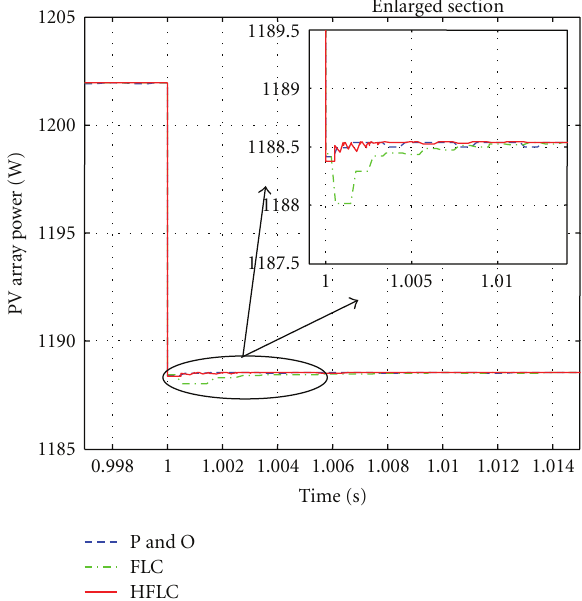
Figure 21: PV output power under sudden temperature change from 25 ◦ C to 30 ◦